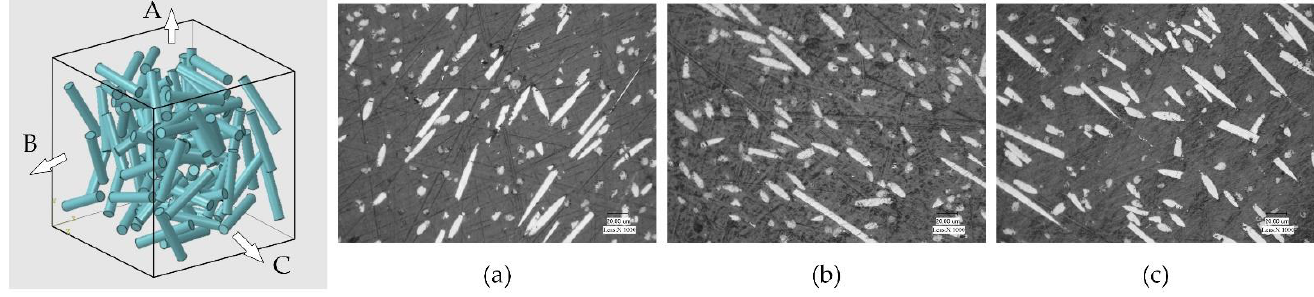
Figure 1. Microstructure photographs of the sample in three different directions, taking CF30/PEEK as an example: ( a ) A direction (x-z plane); ( b ) B direction (y-z plane); ( c ) C direction (x-y plane). Table 1. Mechanical properties of materials used in this work [21,22].